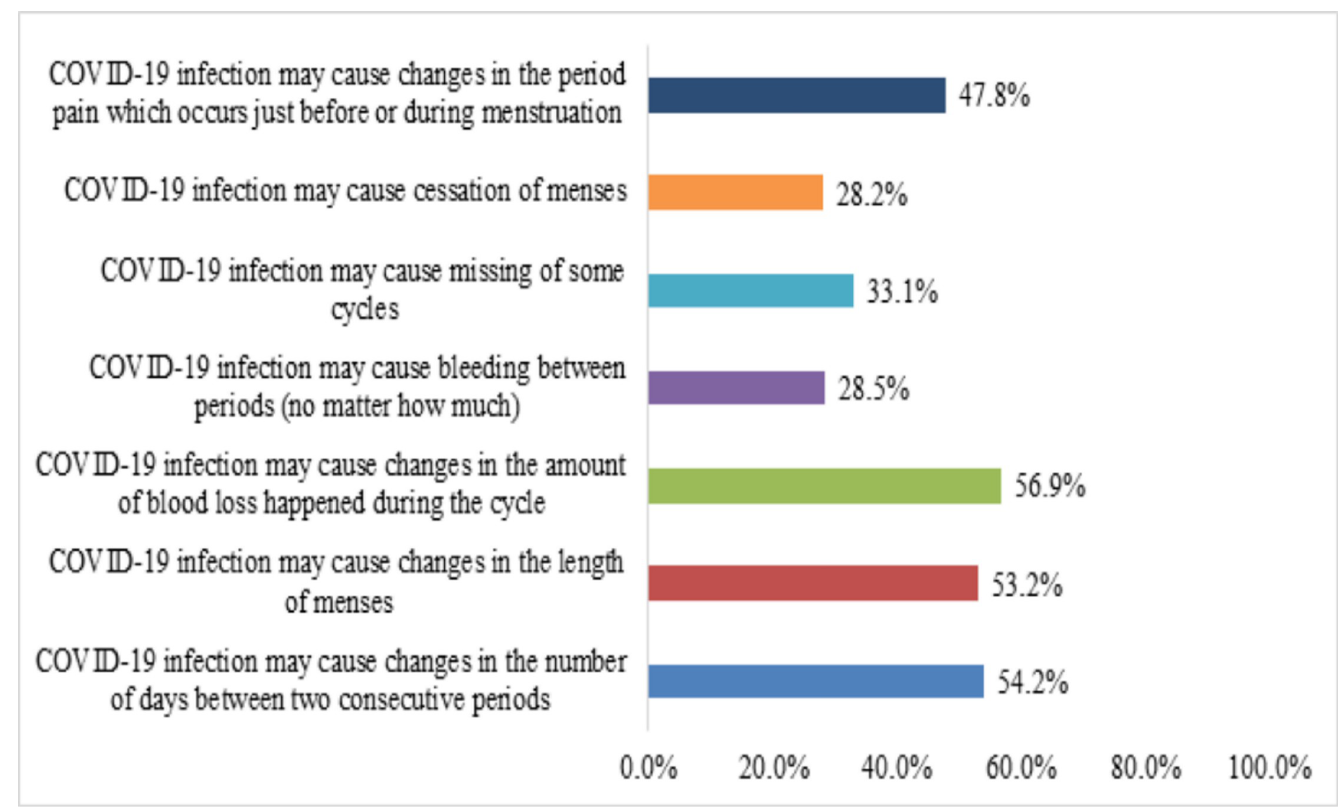
Fig 1. Participants’ perception towards the impact of COVID-19 infection on the menstrual change (n = 483).